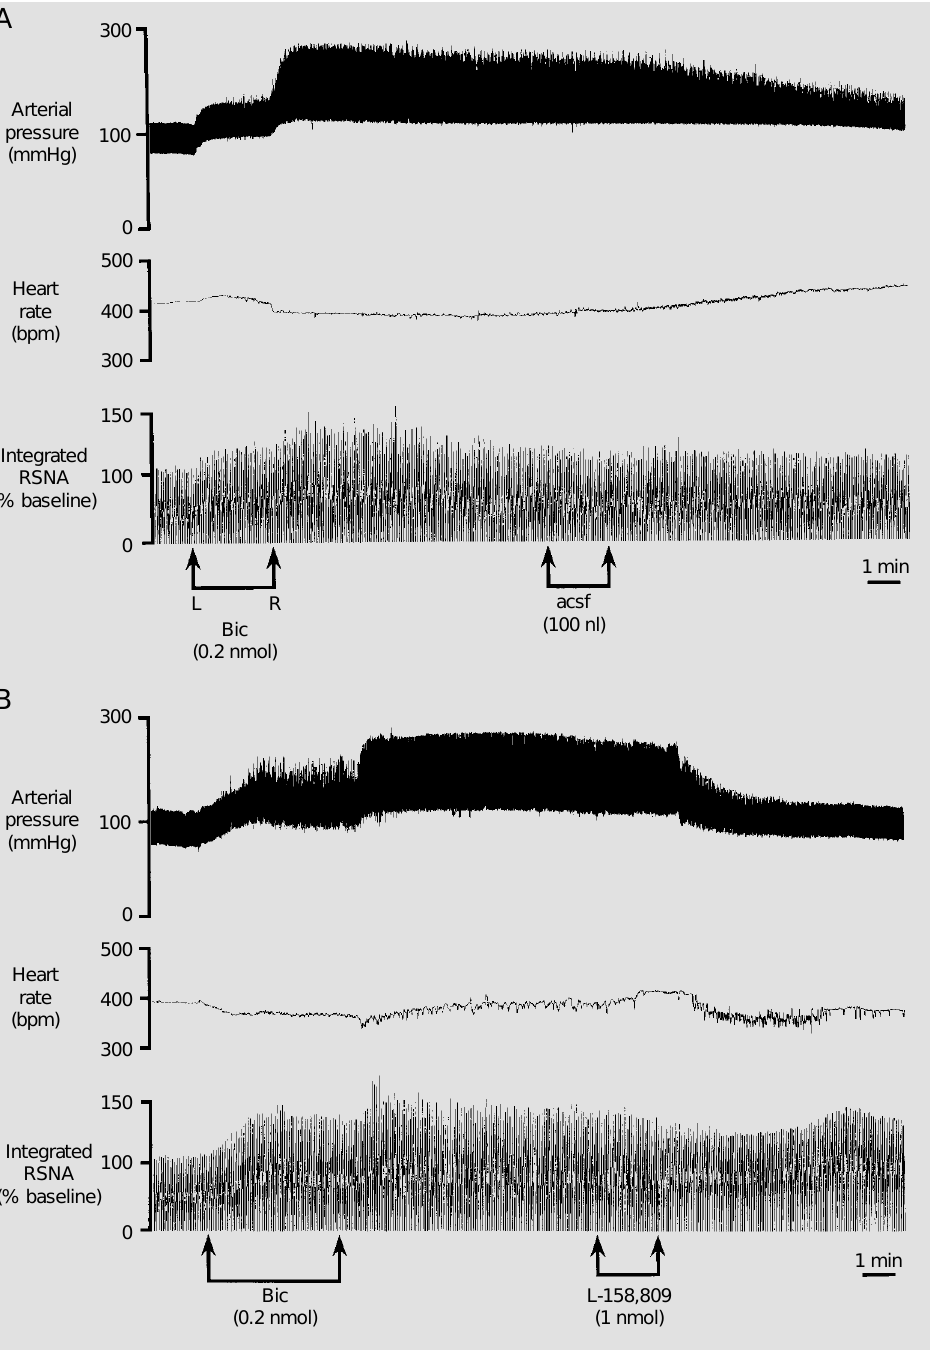
A Figure 5 - Examples of the ef-